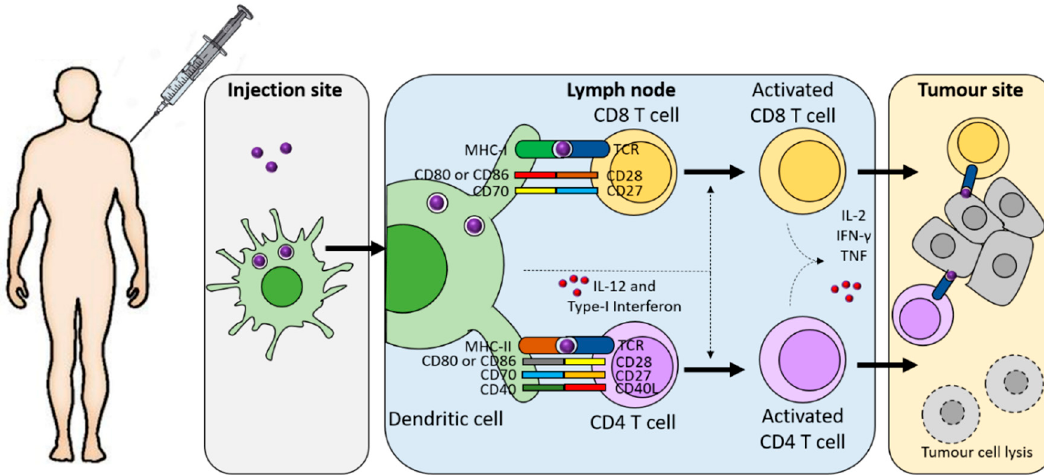
Figure 4. The tumour antigen presentation process induced upon vaccination. The antigen is rapidly taken up by antigen- presenting cells (APCs), such as dendritic cells, at the injection site. Subsequently, the APCs traffic towards the draining lymph nodes, where mature DCs present the antigen-derived peptide on MHC class I molecules and MHC class II molecules to CD8 + and CD4 + T cells, respectively. Several factors, such as costimulatory molecules (CD28, CD27, and CD40) and cytokines (IL-12 and Type-I interferon), concur in the activation of T cells. The generated activated antigen-specific T cell migrate to the tumour site and kill tumour cells through cytotoxicity and the production of effector cytokines, such as IFN- γ and tumour necrosis factor (TNF).